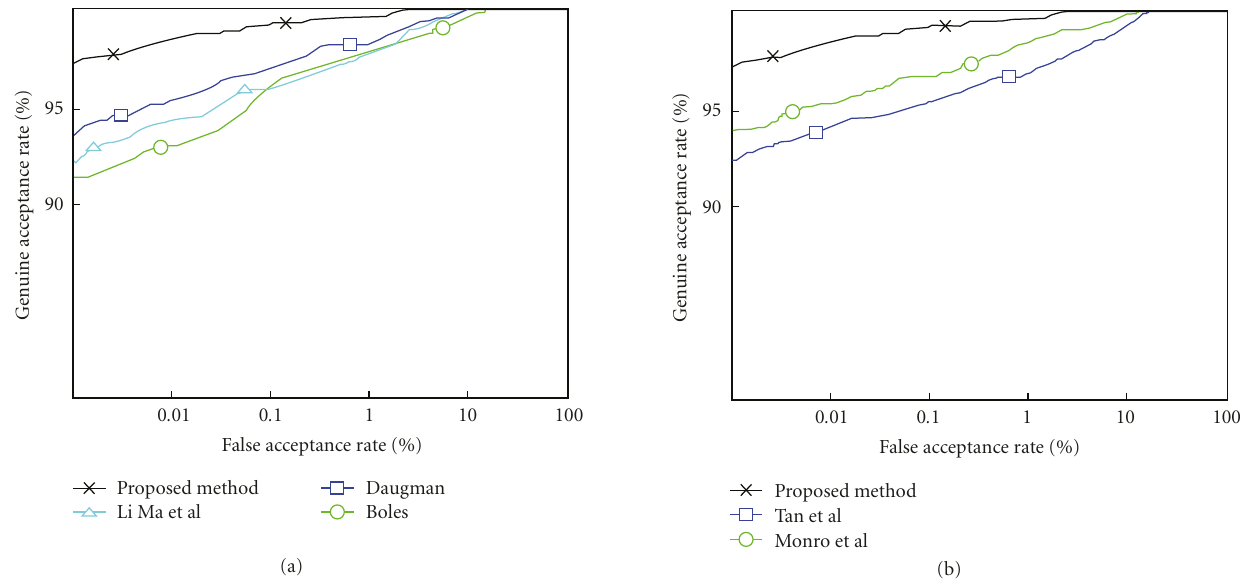
Figure 18: ROC curves of proposed method in comparison with (a) Boles and Boashash [10], Daugman [5], Ma et al. [7], and (b) Monro et al. [15], Halligswroth et al. [27] methods using CASIA-IrisV3 iris database.